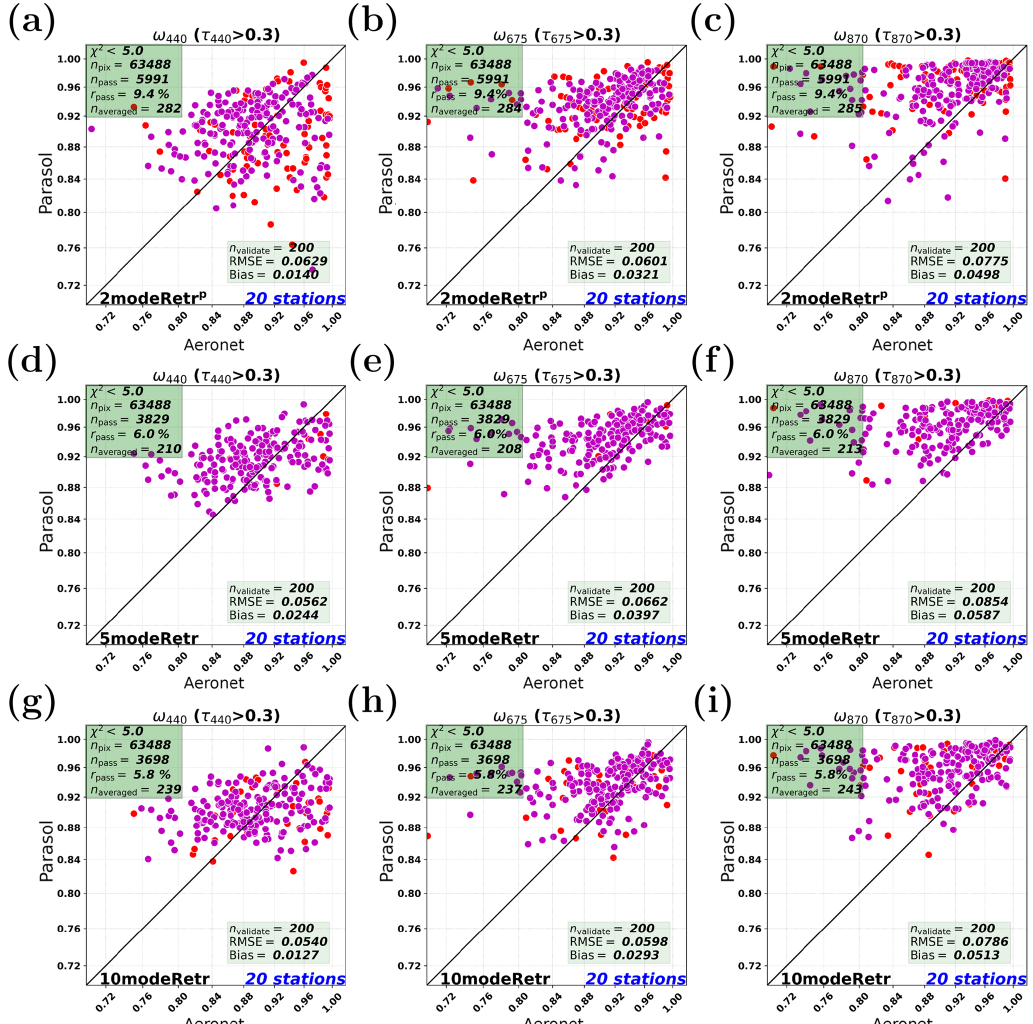
Figure 15. Real data retrievals of SSA among 2modeRetr p , 5modeRetr, and 10modeRetr at different wavelengths. The red and magenta points represent n averaged and n validate points, respectively. Panels (a–c) show 2modeRetr p at 440, 675, and 870nm, respectively. Panels (d–f) show 5modeRetr at 440, 675, and 870nm, respectively. Panels (g–i) show 10modeRetr at 440, 675, and 870nm,